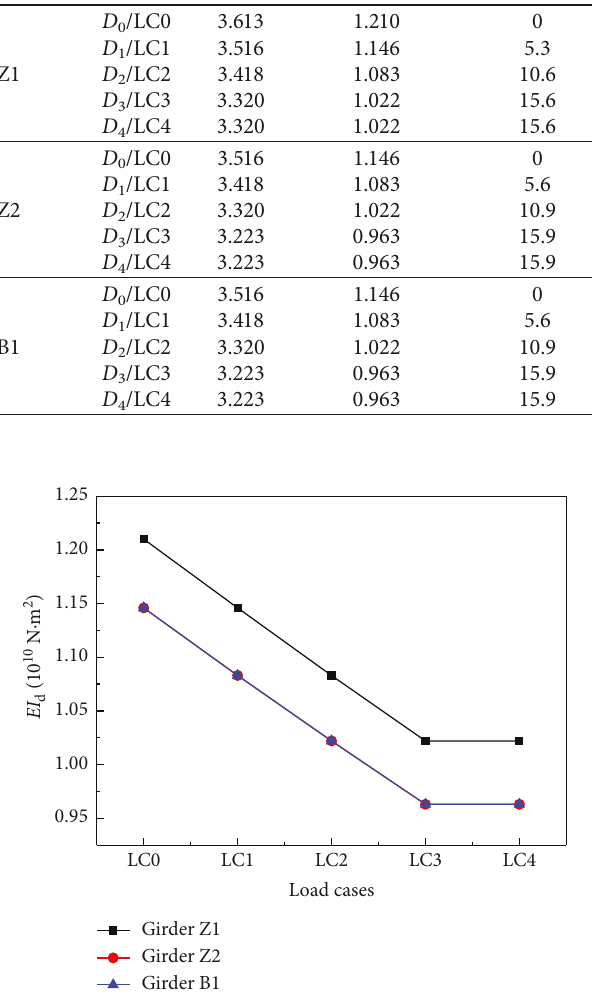
Figure 14: Dynamic stiffness of three girders.